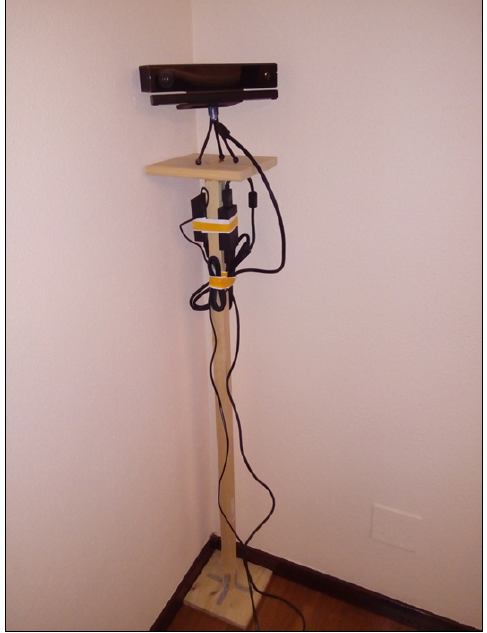
Figure 6. Kinect sensor mounted on a